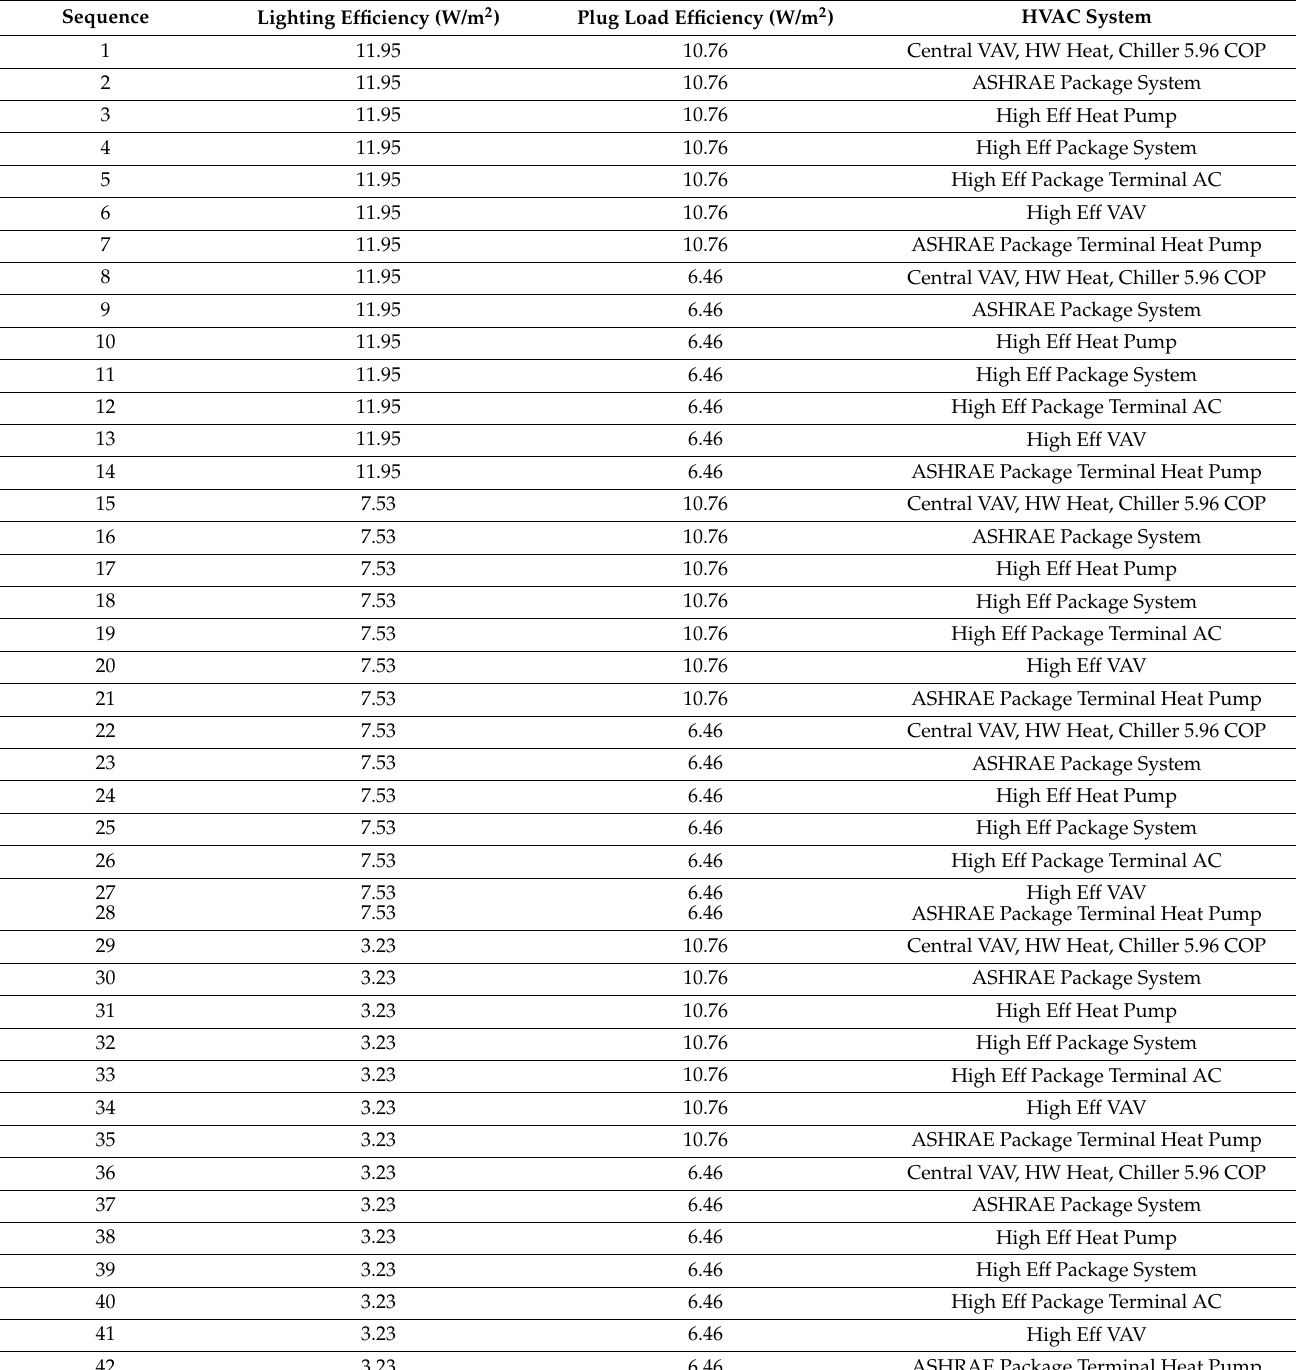
Table 8. The sequence of combinations of Design Factors and